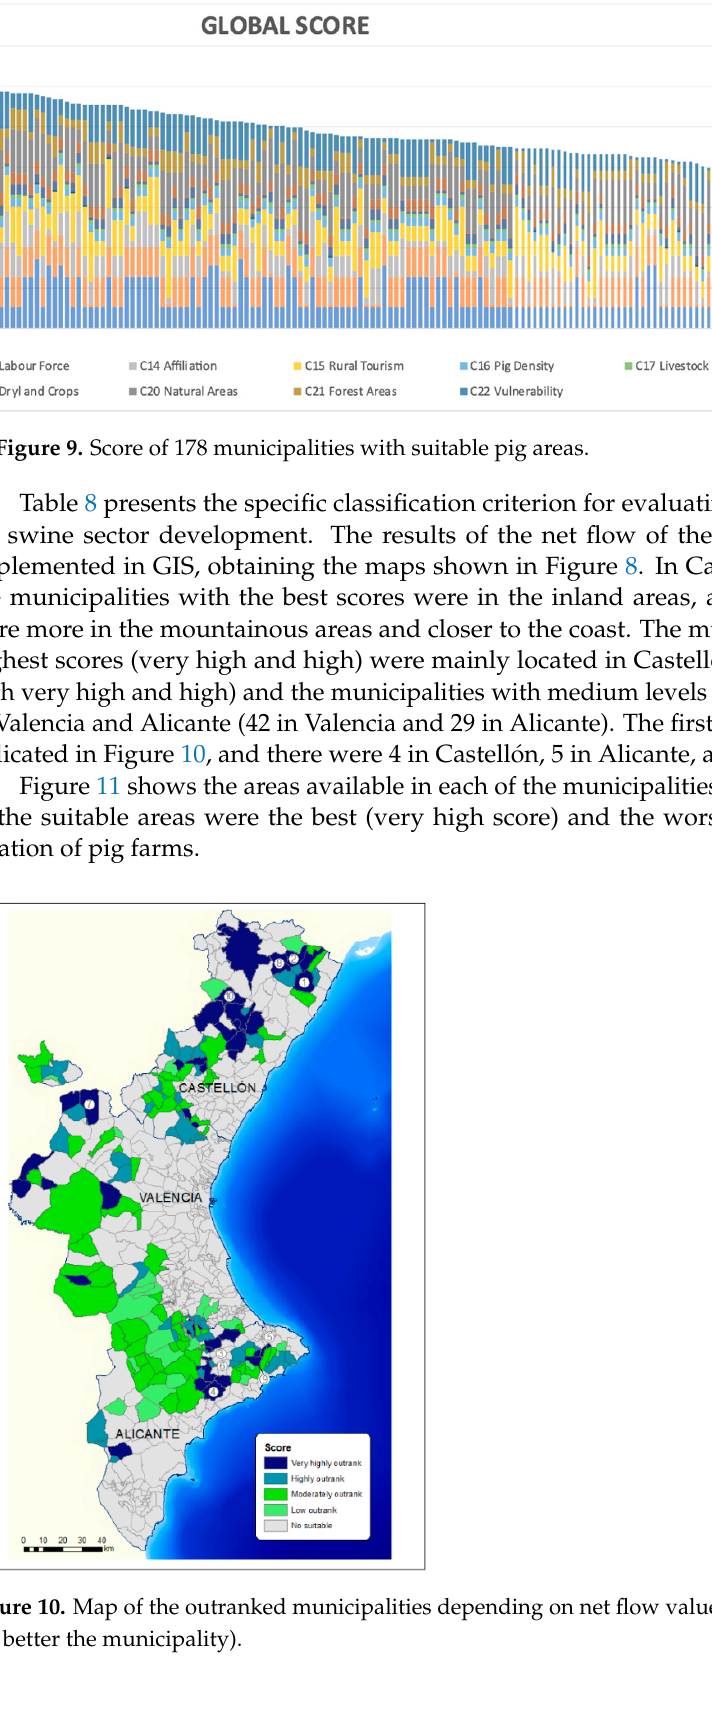
Figure 11. Map of the outranked areas in the suitable municipalities depending on the net flow value (the higher the score is the better the municipality).